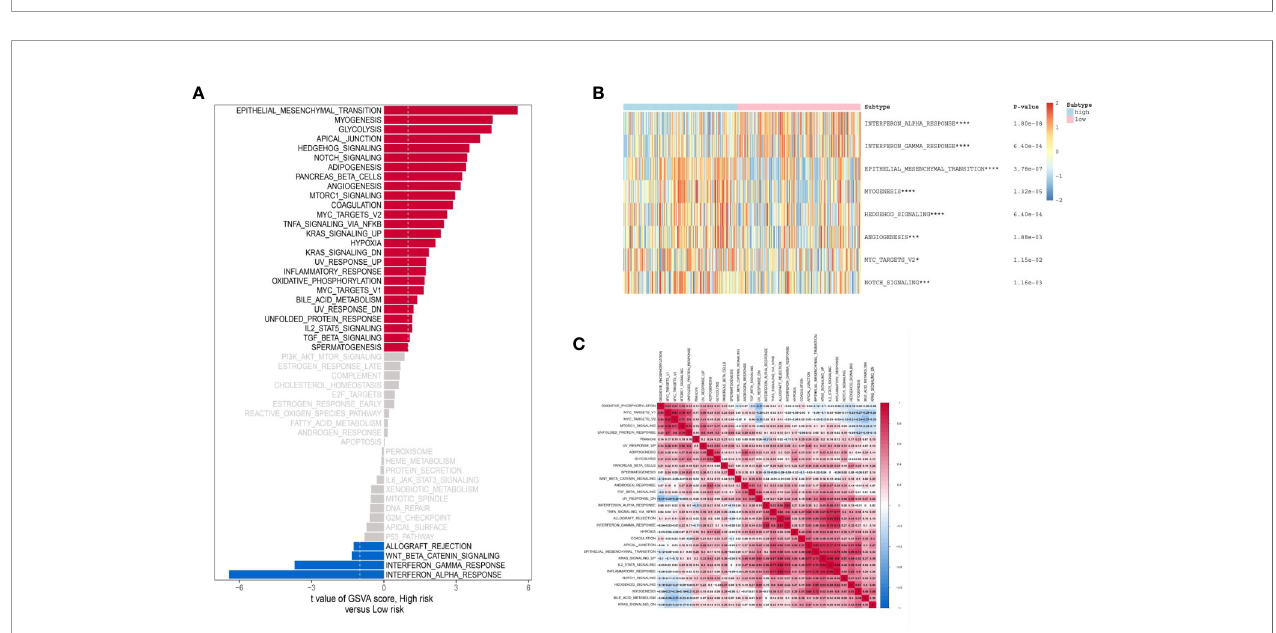
FIGURE 6 | Biologicalfunctionoftwogroupsofpatients. (A) Bar plotof “ Hallmark ” pathwayscorecalculatedbyGSVA fortwogroups ofpatients. HeatmapofGSVAanalysis betweentworiskgroups. (B) Heatmapofmostvaluablepathway. (C) Correlationheatmapbetweeneachpathway.*P< 0.05,***P< 0.005,****P< 0.001.